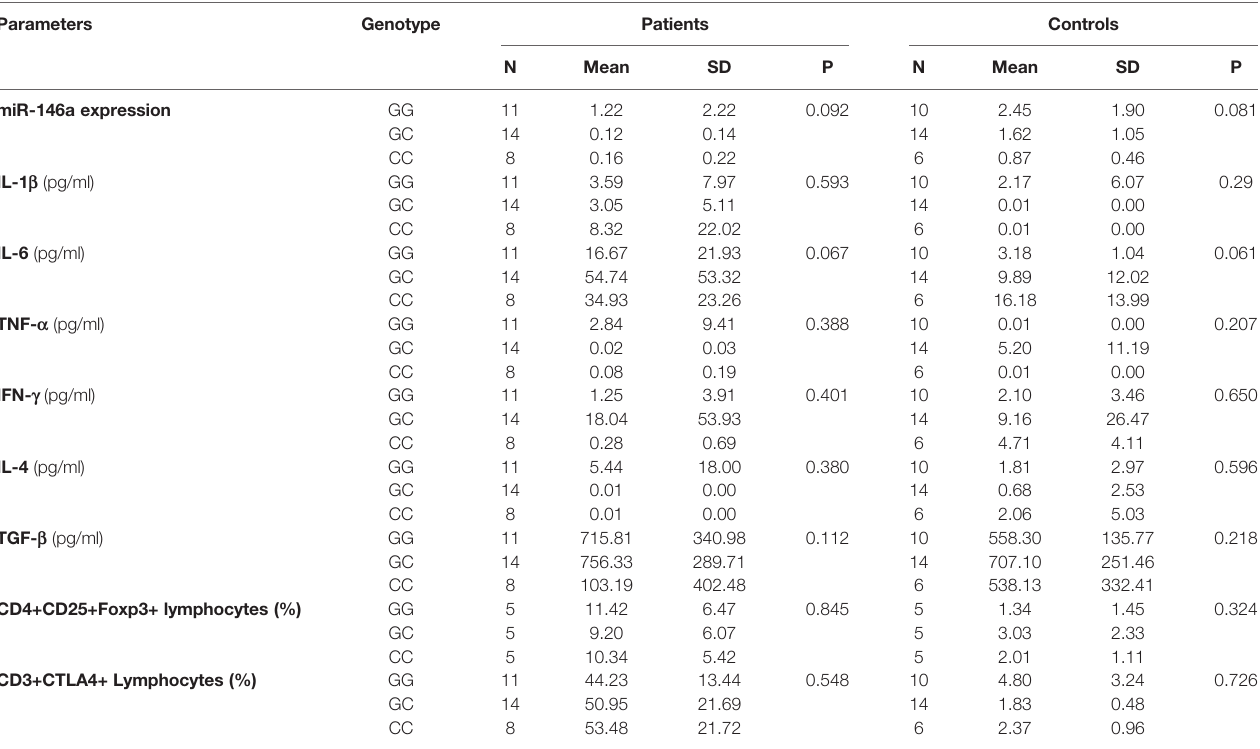
TABLE 7 | Effect of the Rs2910164 genotypes on miR-146a expression, cytokines, and Treg, CD3+CTLA-4+ cells. Parameters